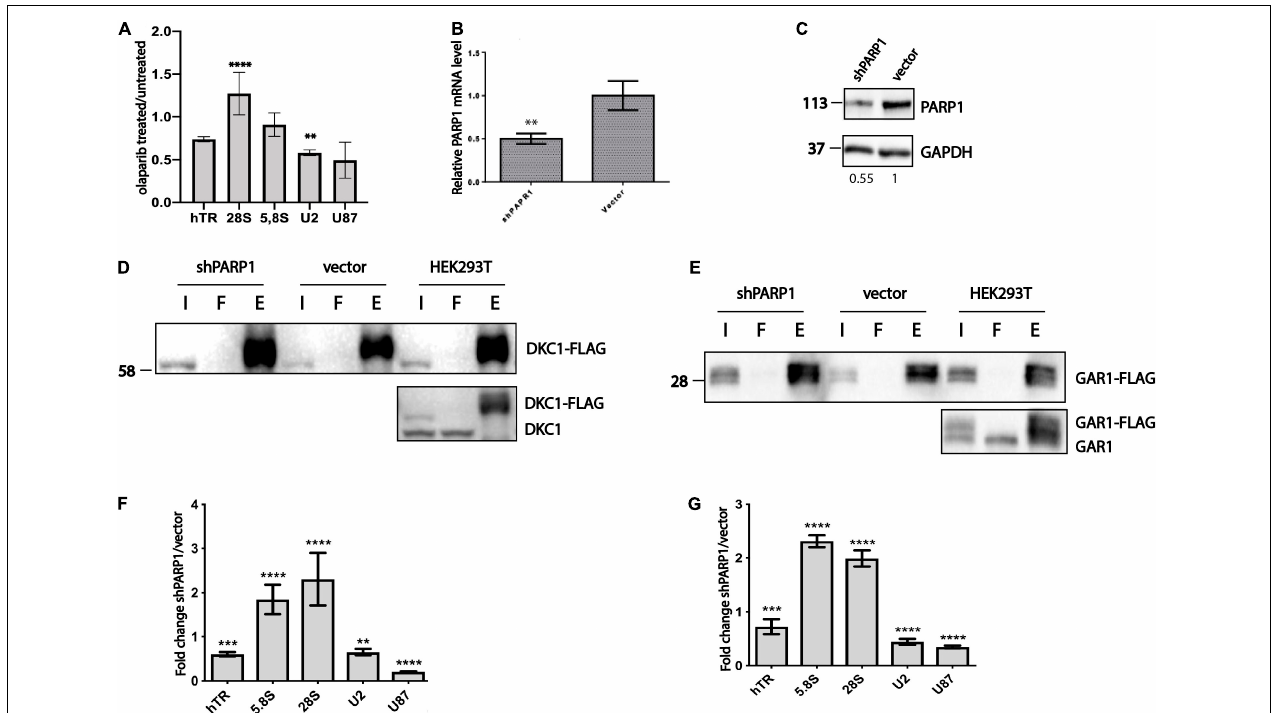
FIGURE 2 | PARylation influences the ability of H/ACA proteins to bind to RNA. (A) RT-qPCR analysis of the levels of RNA co-immunoprecipitated with GAR1 after olaparib treatment and without treatment. The level of RNA associated with GAR1 in cells treated with olaparib was normalized to the level of RNA associated with GAR1 in cells without treatment. The mean values were calculated from triplicate RT-qPCR experiments with three biological replicates, and the bars represent SE. ∗∗∗∗ P < 0.0001 and ∗∗ P < 0.01 using Šidák’s multiple comparisons test. (B) The expression of a shRNA targeting PARP1 mRNA inhibits PARP1 expression, as revealed by RT-qPCR. ** indicates unpaired t -test two tailed p value < 0,01. (C) PARP1 levels are decreased in cells expressing shRNA targeting PARP1 mRNA, as revealed by western blotting. (D) Immunoprecipitation of DKC1-3xFLAG from HEK293T cells was followed by immunoblotting with anti-FLAG antibodies (upper panel) and with anti-DKC1 antibodies (lower panel). I – input, F – flow-through, E – elution. (E) Immunoprecipitation of GAR1-3xFLAG from HEK293T cells was followed by immunoblotting with anti-FLAG antibodies (upper panel) and anti-GAR1 antibodies (lower panel). I – input, F – flow-through, E – elution. (F) RT-qPCR analysis of the levels of RNA co-immunoprecipitated with DKC1. The mean values were calculated from triplicate RT-qPCR experiments with three biological replicates, and the bars represent SE. ∗∗∗∗ P < 0.0001 and ∗∗∗ P < 0.001 using Šidák’s multiple comparisons test. (G) RT-qPCR analysis of the levels of